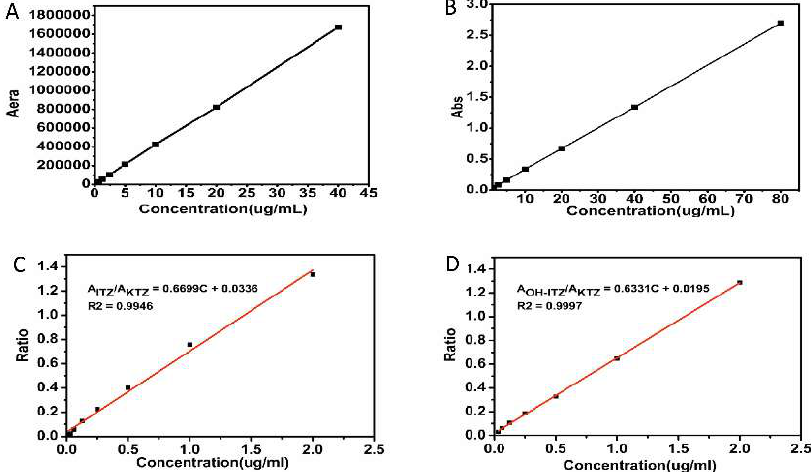
Figure 1. Calibration curves of ( A ) ITZ (itraconazole) in HPLC (high performance liquid), ( B ) ITZ in UV (ultraviolet-visible) spectrophotometry, ( C ) ITZ (plasma) in HPLC, ( D ) OH-ITZ (hydroxyitraconazole) (plasma) in HPLC.